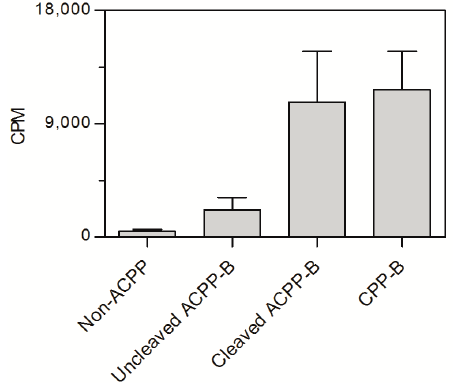
Figure 5. Cellular uptake of 177 Lu-non-ACPP, uncleaved 177 Lu-ACPP-B, pre-activated 177 Lu-ACPP-B, and 177 Lu-CPP-B after 3h incubation with HT-1080 cells, assessed by γ -counting. Data are presented as mean ±